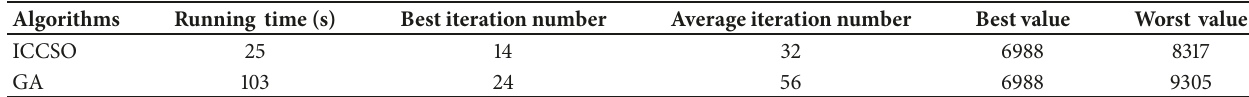
Table 5: Comparison of optimization results for two methods.